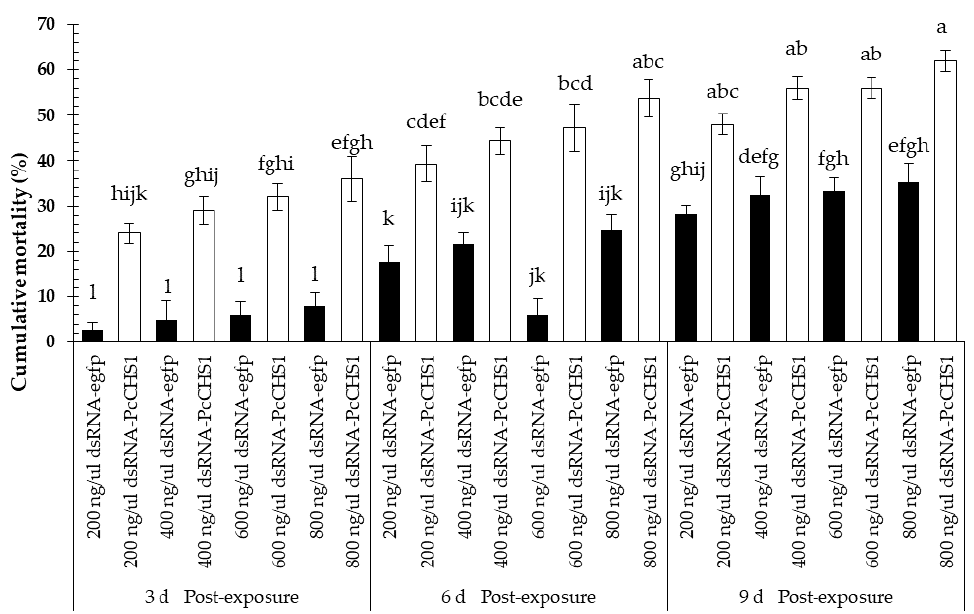
8 of 19 Figure 3. Time-mortality response of P. citri larvae upon exposure to the target gene ( PcCHS1 ),